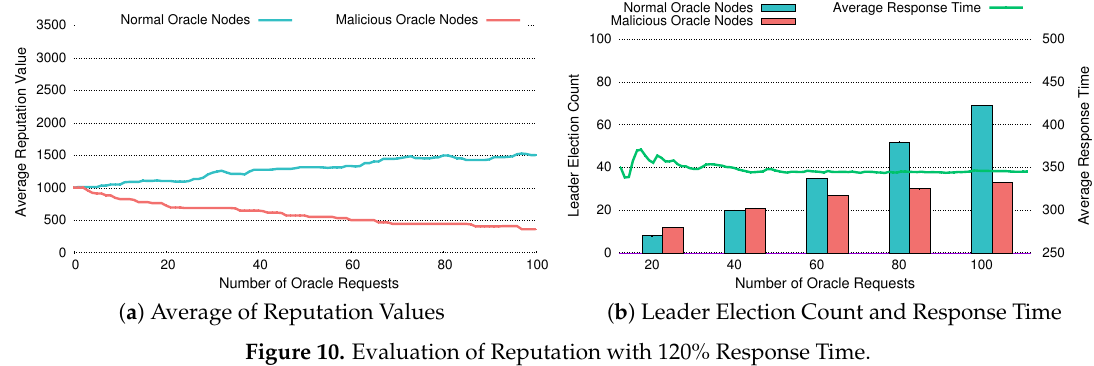
Figure 10. Evaluation of Reputation with 120% Response Time.